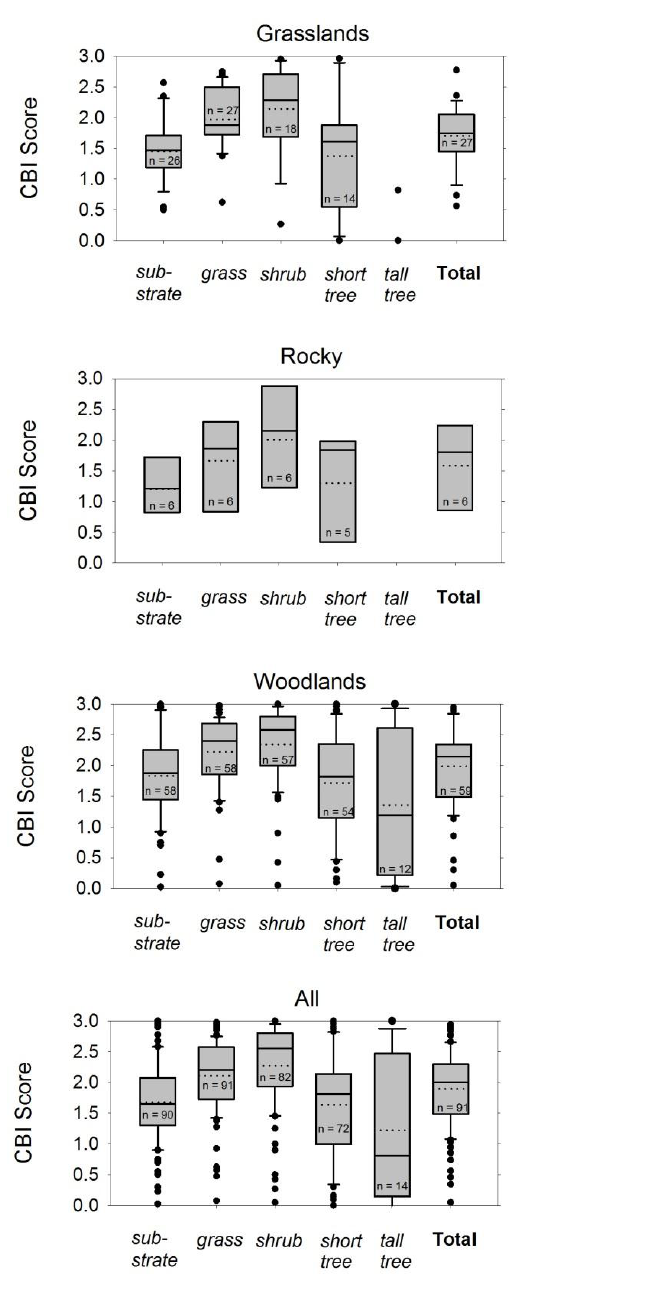
Figure 4. Box plots summarizing stratum scores and total plot CBI scores. Plots show differences in stratum scores by land-types and for all land-types combined. The boundary of the box closest to zero indicates the 25th percentile, the line within the box marks the median, and the boundary of the box farthest from zero indicates the 75th percentile. Whiskers (error bars) above and below the box indicate the 90th and 10th percentiles. Means are represented by the dotted